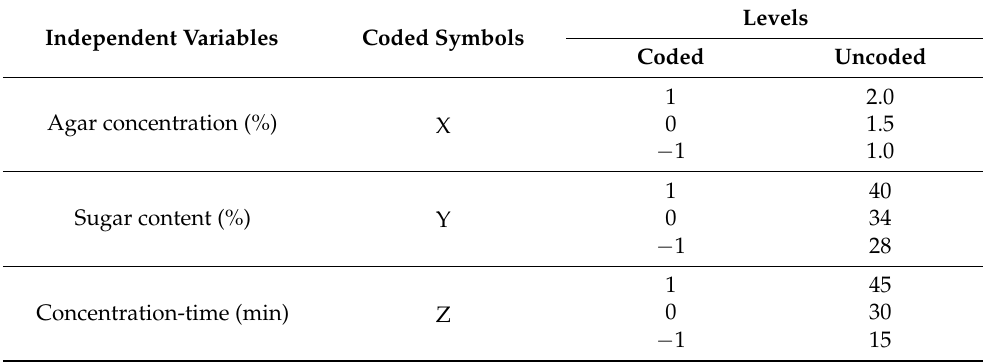
Table 2. Process variables and their levels in the three variables — three levels response surface design of gelatinized adzuki-bean cake.